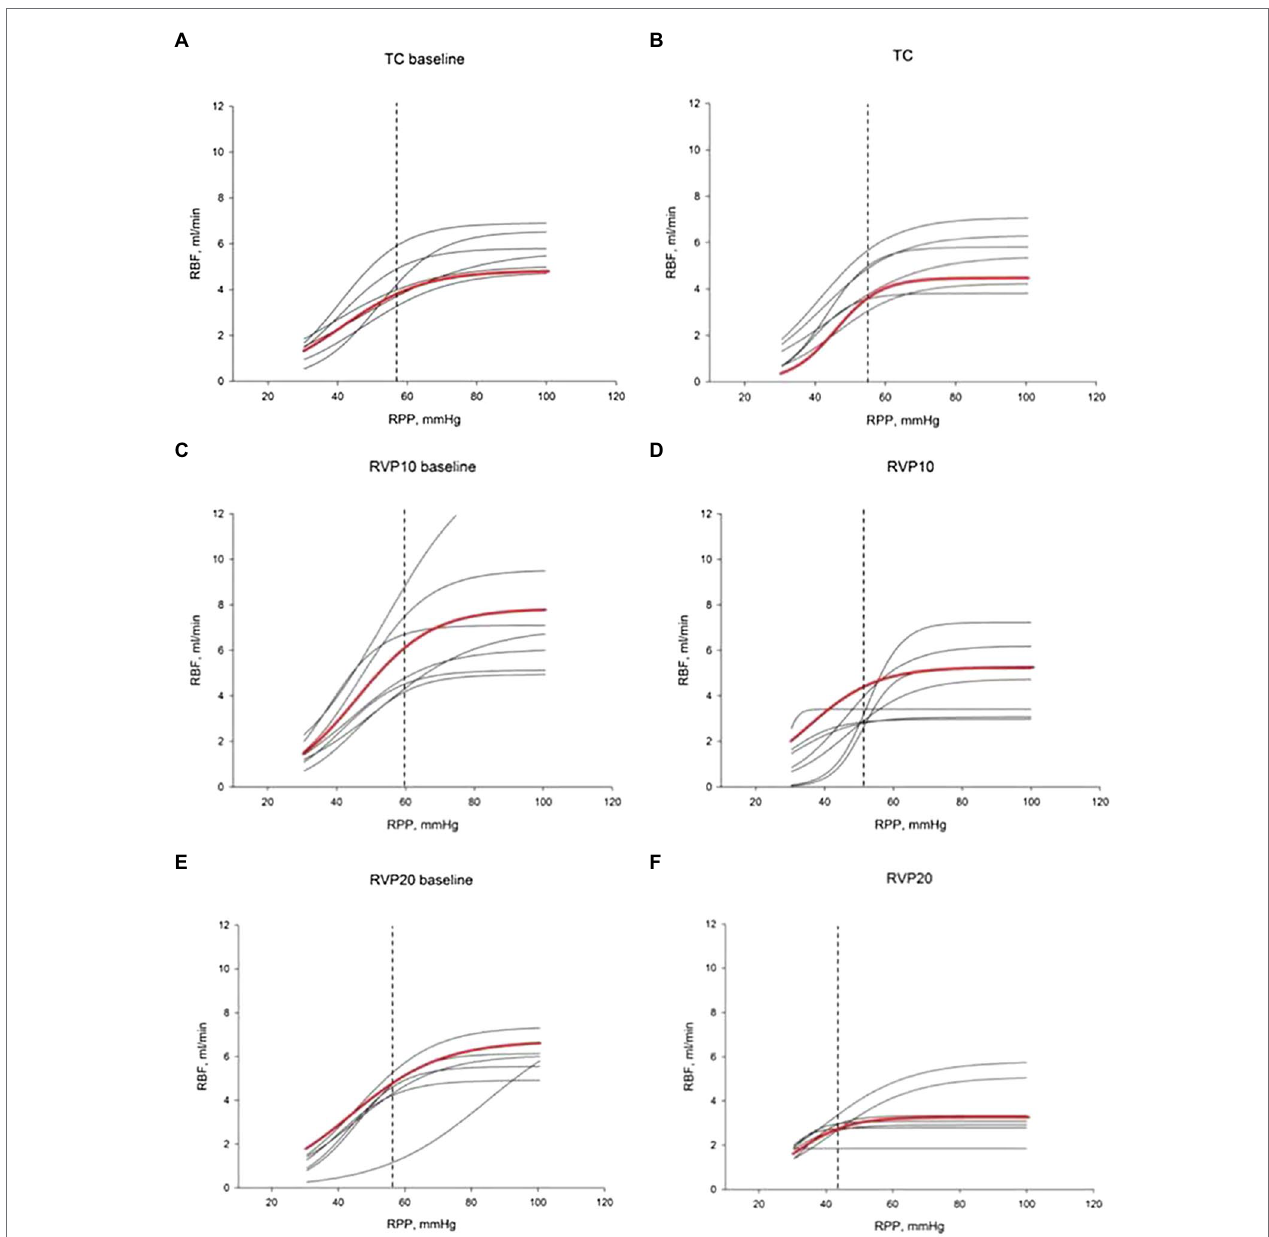
FIGURE 4 | Renal blood flow autoregulation curves. Each curve is generated by nonlinear regression analysis. (A,C,E) show baseline autoregulation curves before RVP manipulation. (B,D,F) show autoregulation curves without RVP elevation ( B , TC, n = 6), with RVP elevation of ~10 mmHg ( D , RVP 10, n = 8) and with RVP elevation of ~20 mmHg ( F , RVP 20, n = 8). The red curve indicates the average of the curves. The lower limit of RBF autoregulation is indicated by the vertical dashed